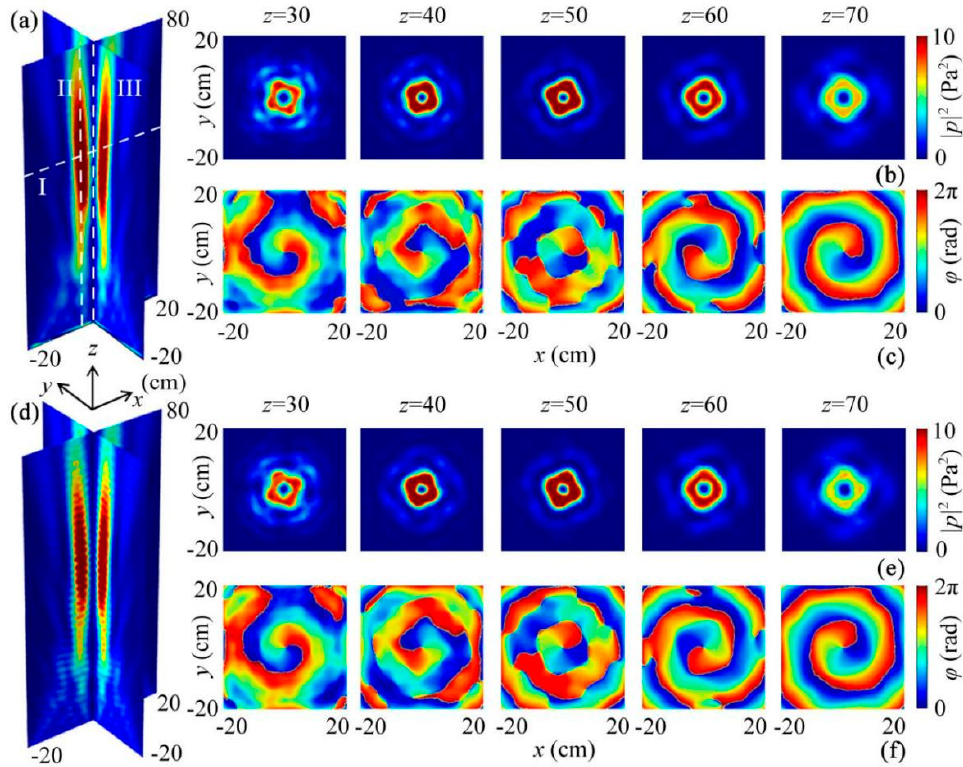
Figure 3. The performance of the reflected ABV beam with n = 1 at 9.0 kHz. ( a ) Simulated 3D reflected intensity distribution of the ABV beam created by the quasi-3D metasurface, and its corresponding reflected ( b ) intensity and ( c ) phase distributions at 5 selected cross sections z = 30, 40, 50, 60, and 70 cm. ( d ) Simulated 3D reflected intensity distribution of the ABV beam created by the theoretical continuous phase profile, and its corresponding reflected ( e ) intensity and ( f ) phase distributions at the 5 cross sections.